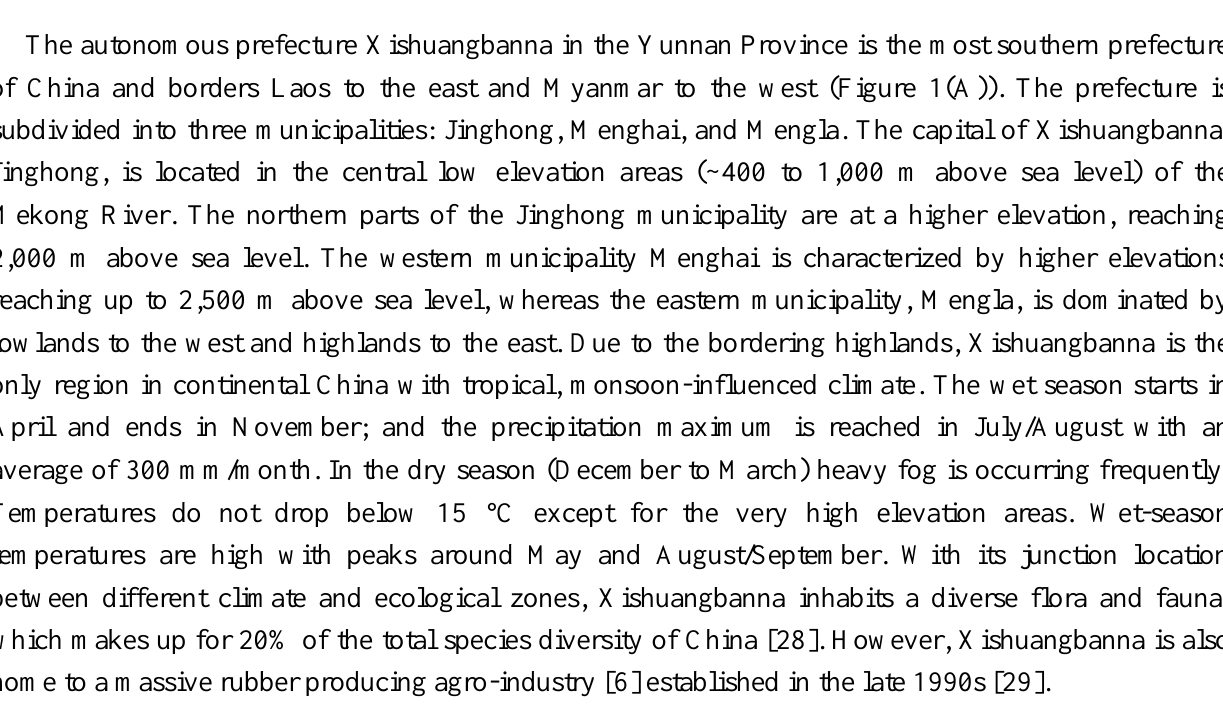
Figure 1. ( A ) Topography of the study area. ( B ) Location of the study area. ( C ) Available Quickbird